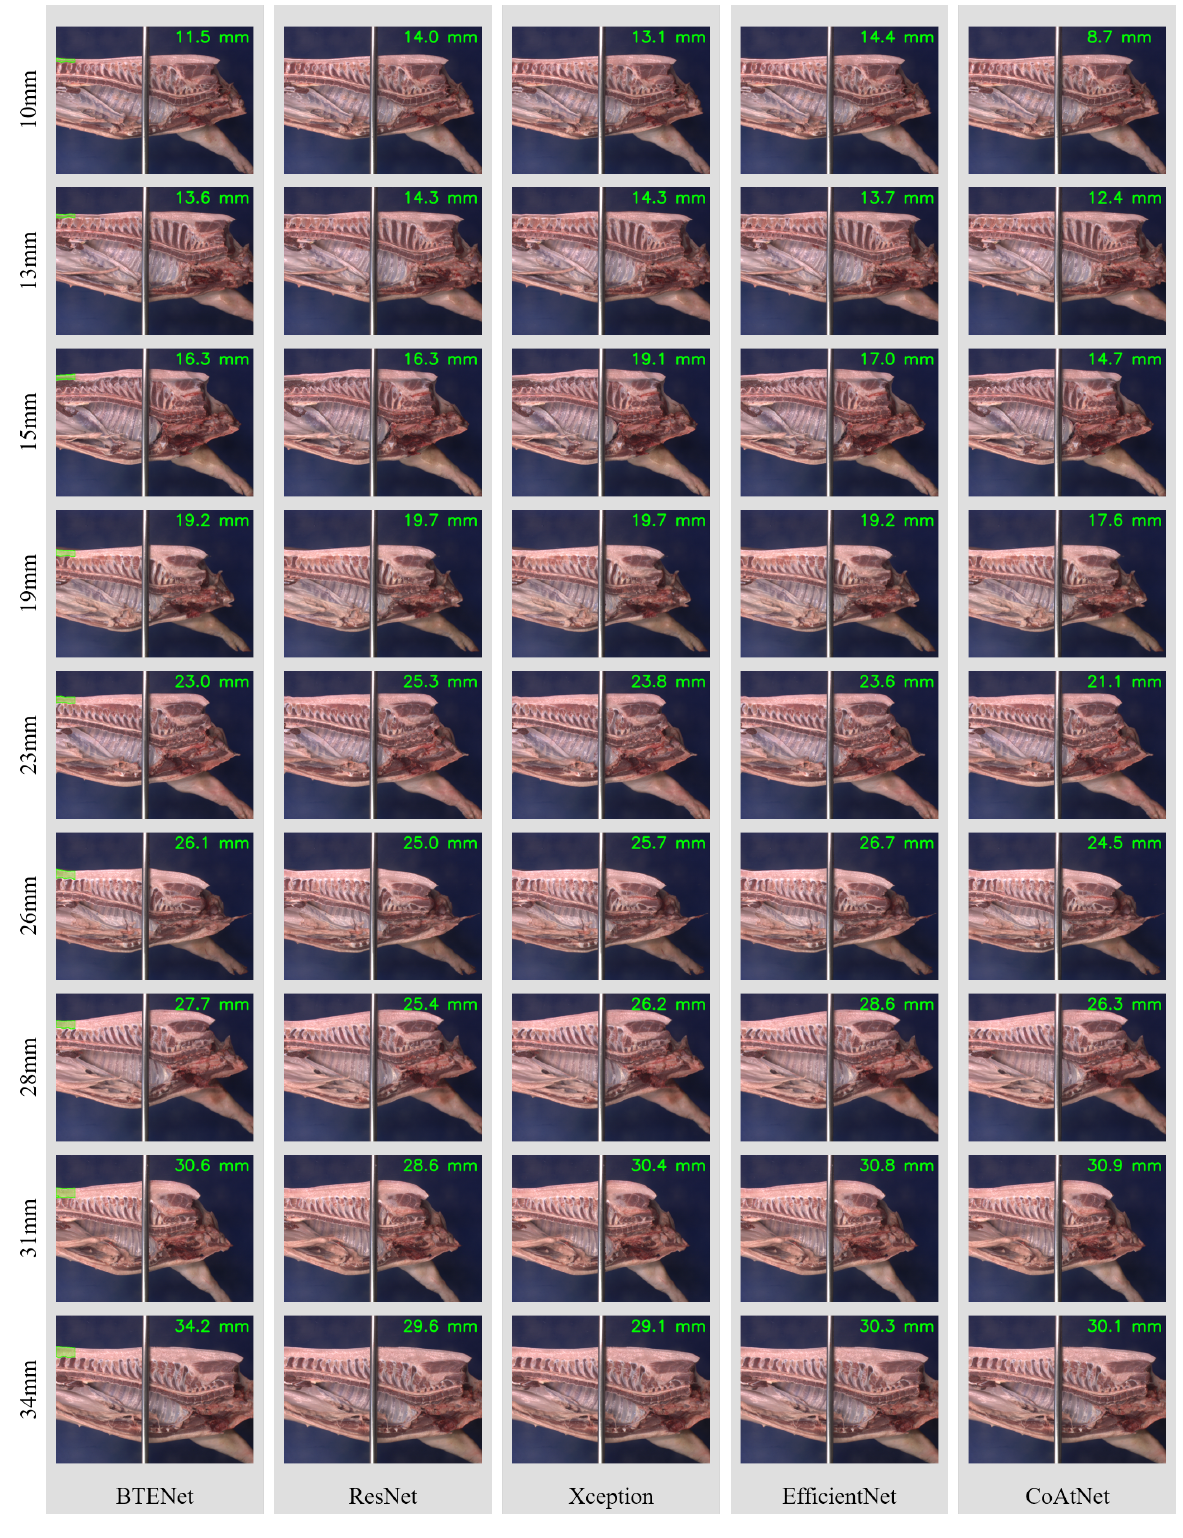
Figure 5. Qualitative comparison of the PigBT test set of different approaches. Text on the left side represents a ground-truth back-fat thickness. A top-right number (green text) in each image denotes an estimated back-fat thickness. The estimated back-fat area of BTENet is delineated in